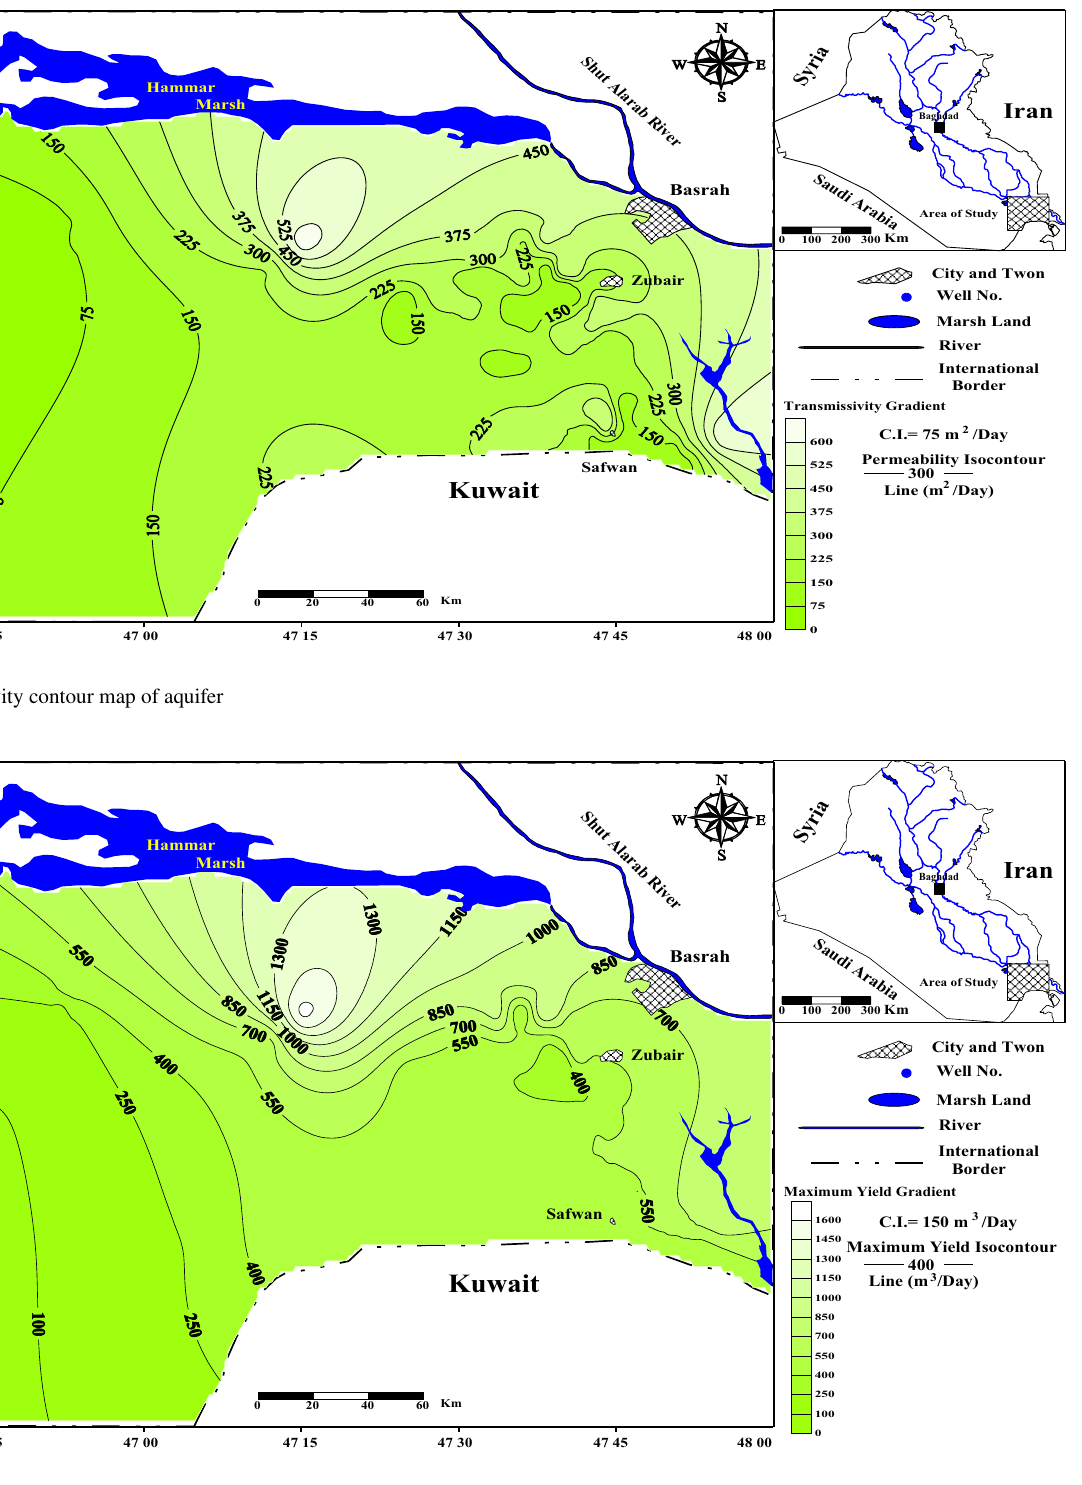
Fig. 6 Maximum yield contour map of the